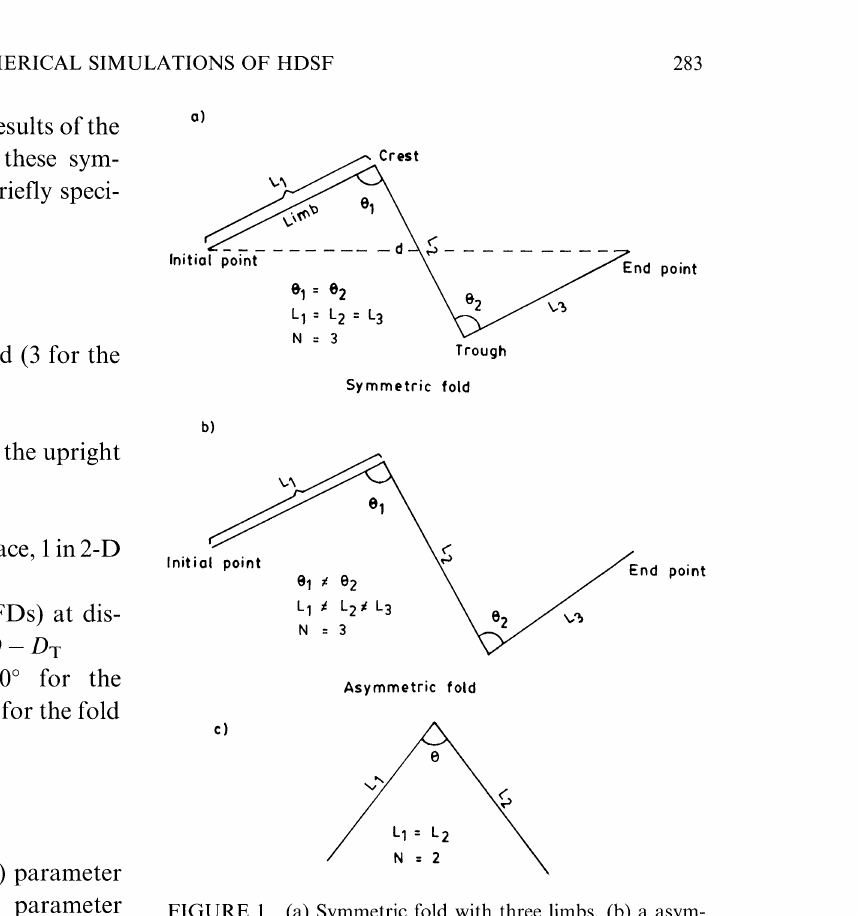
(a) Symmetric fold with three limbs, (b) a asym- metrical fold pattern and (C) symmetric fold with two